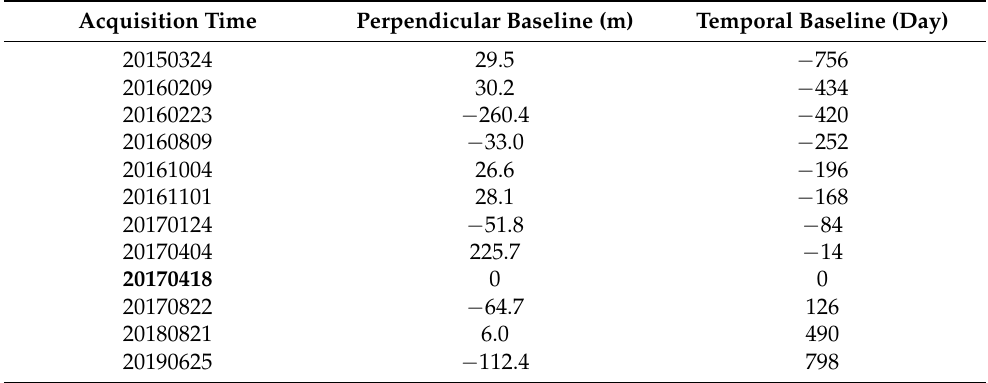
Table 2. Perpendicular and Temporal Baseline List of ALOS PALSAR-2 TSPolInSAR data.